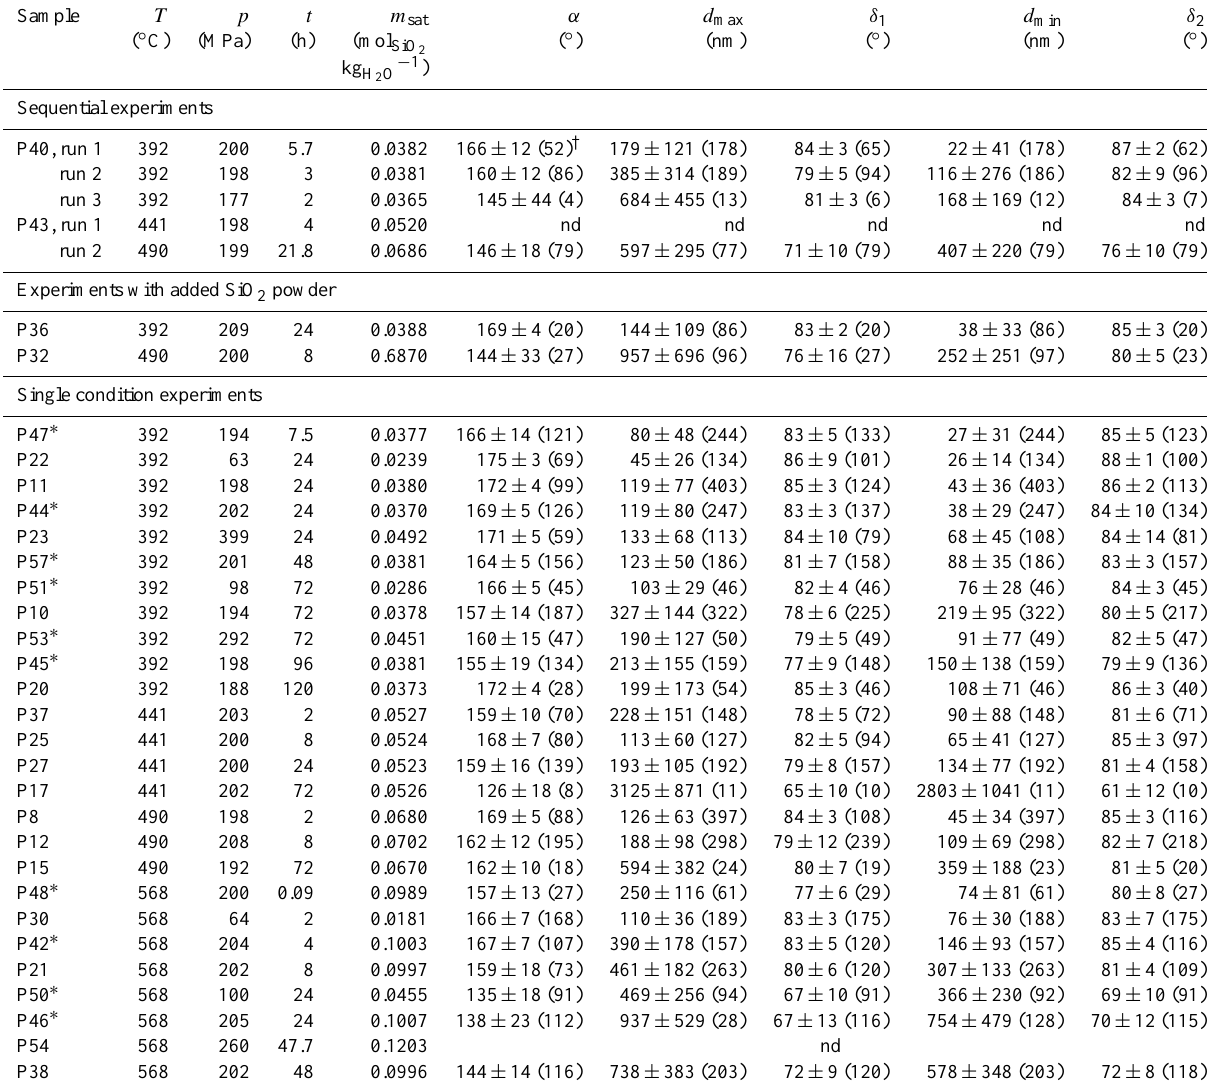
Table 2. Conditions and results of the conducted hydrothermal annealing